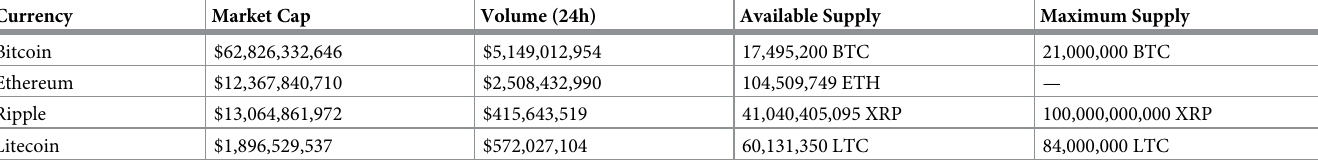
Table 1. Market capitalization and trade volume information for selected virtual